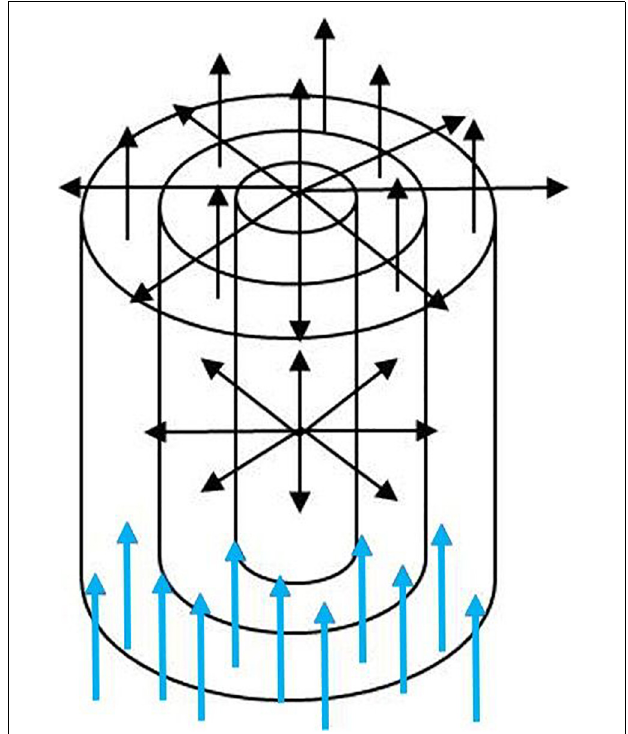
FIGURE 10 | The constant inflow of acetone (blue arrows) into the cylinder established a diffusion of the mixture/fluid. The acetone/water mixtures can flow through surface and lid/bottom of the cylinder (shown are some radial layers which the fluid is passing